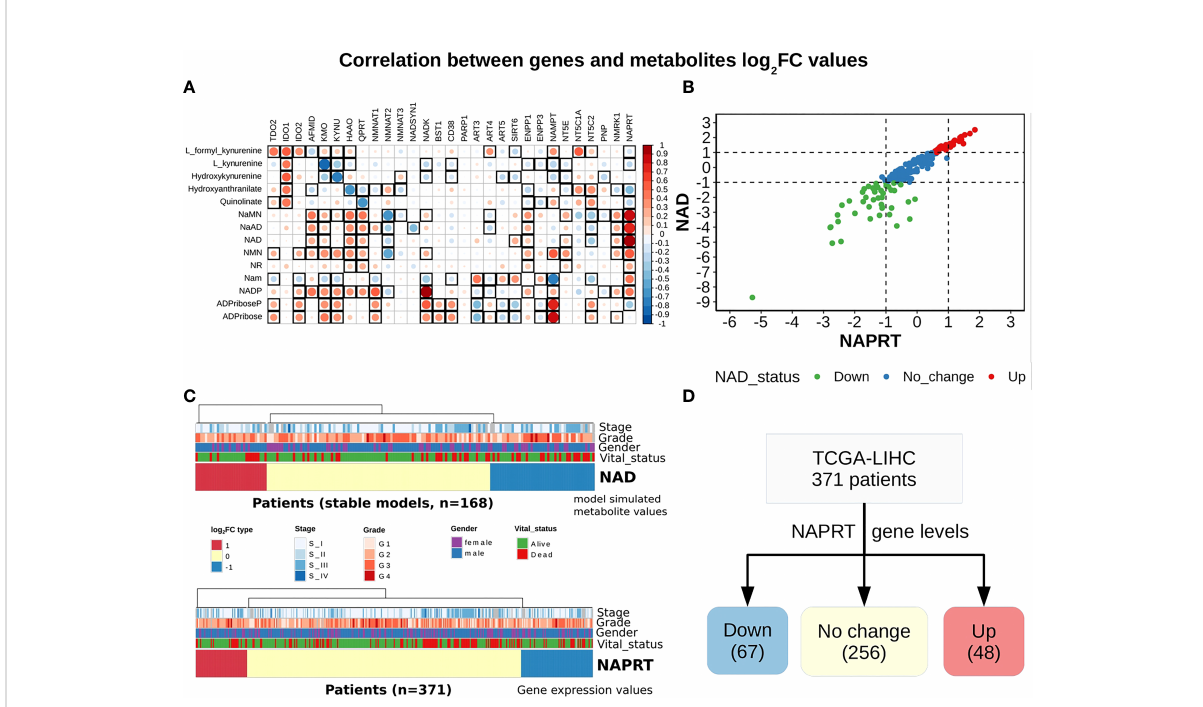
FIGURE 3 NAPRT alone is suf fi cient to indicate the NAD status in patients. (A) Correlogram between gene log 2 FC values and metabolite log 2 FC values. Rows represent metabolites and columns represent genes. The red colour corresponds to positive correlation, the blue colour corresponds to negative correlation, the area covered in the square corresponds to the absolute value of the correlation, and the black squares correspond to signi fi cant correlations (p-value < 0.05). Rows and columns are arranged based on the routes mentioned in Figure 1A. (B) Correlation plot showing the NAPRT and NAD log 2 FC values. The X-axis represents NAPRT log 2 FC values and the Y-axis represents NAD log 2 FC values. The points are coloured based on the NAD status of the samples. Red points indicate NAD up samples, blue points indicate NAD no change samples, and green points indicate NAD down samples. (n = 168) (C) Above panel shows the heatmap of NAD log 2 FC values obtained after steady-state analysis, rows correspond to NAD groups and columns correspond to patients (n = 168). The Red colour represents up NAD levels (log 2 FC ≥ +1), blue colour represents NAPRT down levels (log 2 FC ≤ -1), yellow colour represents NAD no change levels (-1 < log 2 FC < +1). The below panel shows the heatmap of NAPRT log 2 FC values in tumour tissue calculated with respect to the normal tissue, rows correspond to NAPRT groups and columns correspond to patients (n = 371). The Red colour represents up NAPRT levels (log 2 FC ≥ +1), the blue colour represents NAPRT down levels (log 2 FC ≤ -1), yellow colour represents NAPRT no change levels (-1 < log 2 FC < +1). Columns are arranged based on the complete hierarchical clustering method. Annotations on the top of the heatmap are Stage, Grade, Gender, and Vital status (refer to the key in the image for more details). (D) Schematic showing the division of patients into three groups based on NAPRT gene